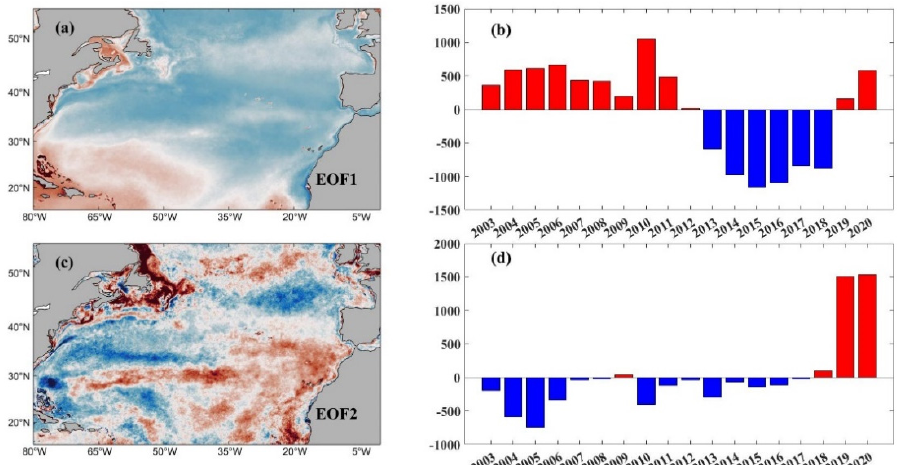
Figure 9. The results of EOF analysis of surface pCO 2 in the North Atlantic from 2003 to 2020. ( a ) The spatial distribution of the first principal component. ( b ) The temporal distribution of the first principal component. ( c ) The spatial distribution of the second principal component. ( d ) The temporal distribution of the second principal component.